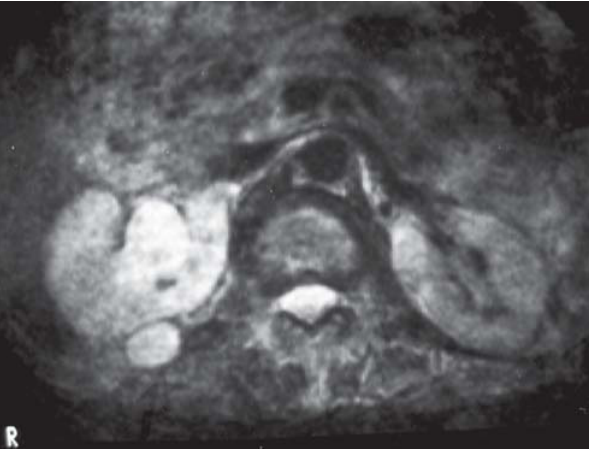
Figure 3 - T2-weighted abdominal MRI showing a 3 x 2.8 x 2.5-cm right retrorenal mass with high signal